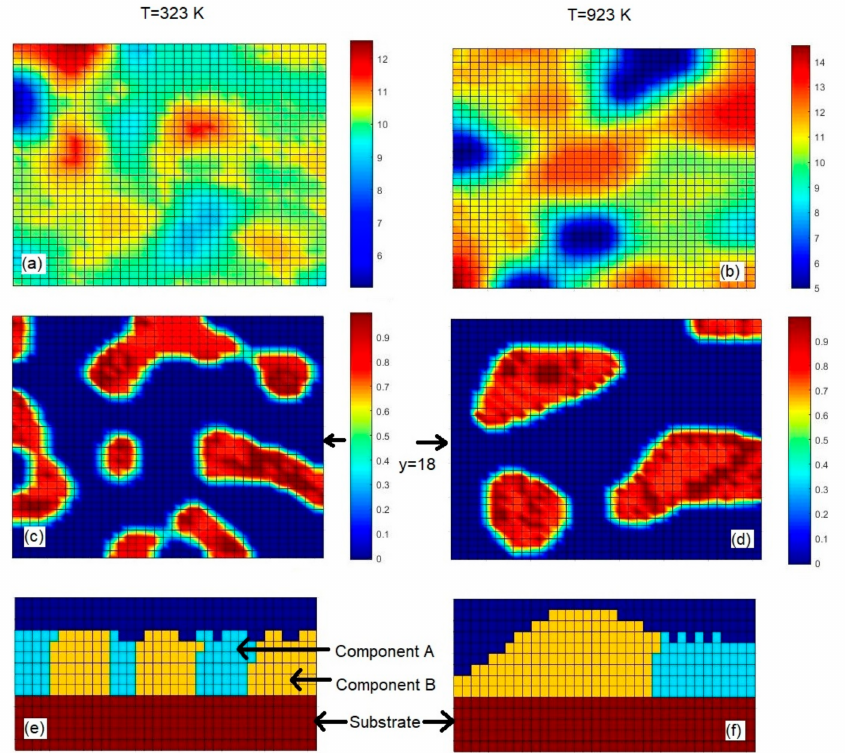
Figure 5. Thesurfacemaps( a , b ), concentrationplotsofcomponent A (inthesurfacelayerofthinfilms)( c , d ), and cross-sectional views ( e , f ) calculated at the substrate temperatures of 323 K ( a , c , e ) and 923 K ( b , c , f